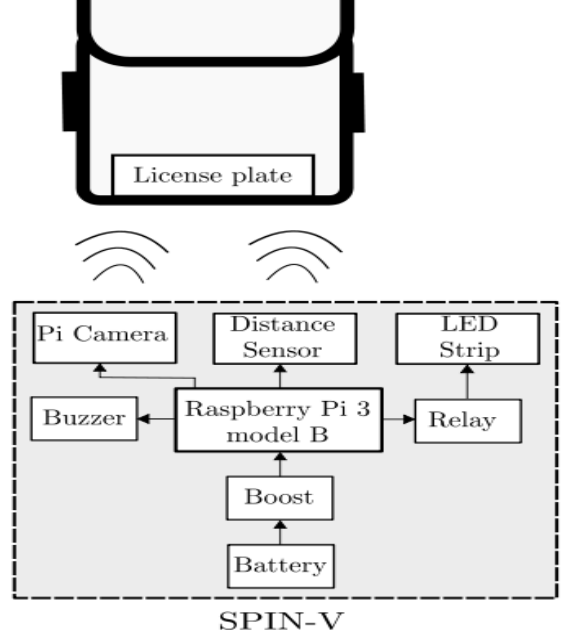
Figure 13. Connection diagram